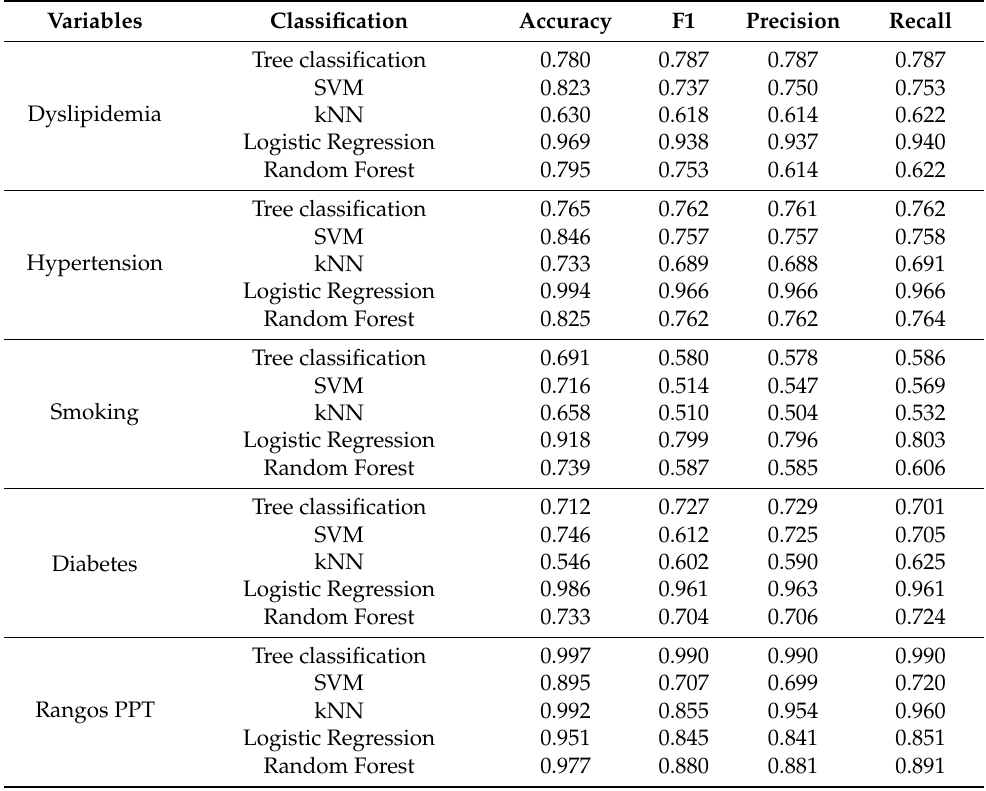
Table 4. Cross-Validation results using a target FRCV decision tree